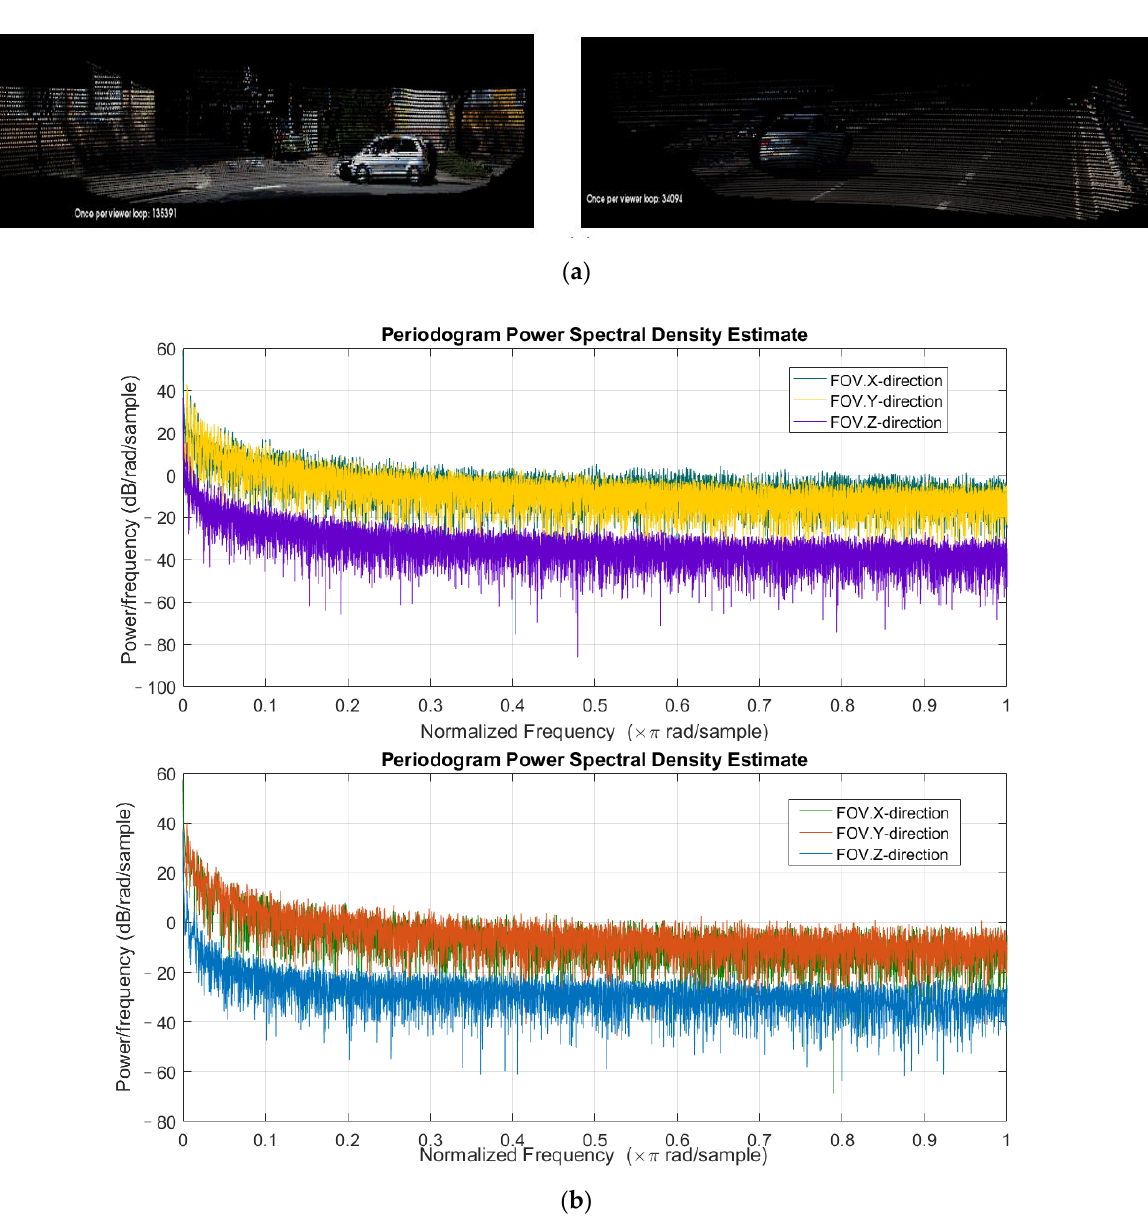
Figure 4. The FOV estimation results and the periodic spectral estimation. ( a ) 3D point cloud sampling results; ( b ) Power spectra in different directions.